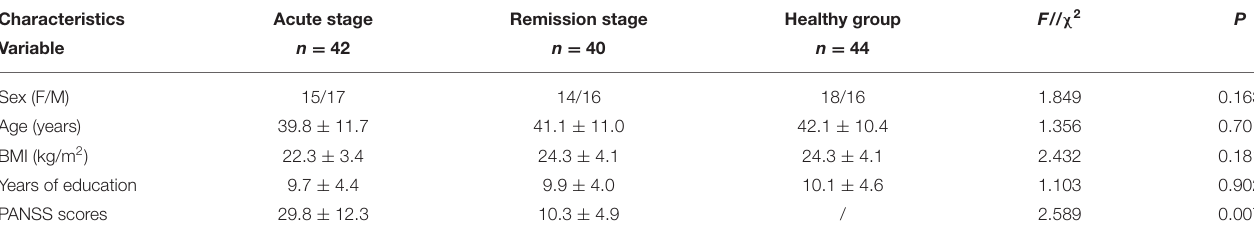
TABLE 1 | Baseline characteristics of the three groups. Characteristics